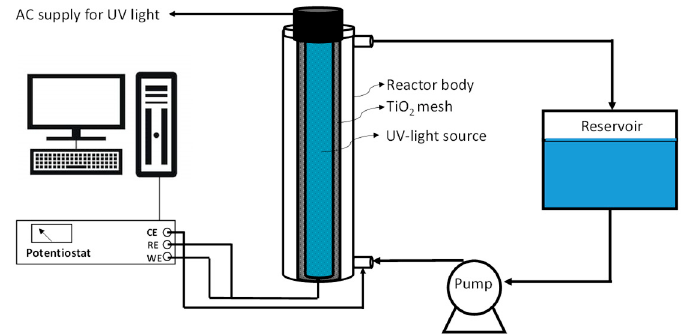
Figure 9. Schematic of the laboratory-scale electrochemical photoreactor working in up-flow condition and semi-batch mode.